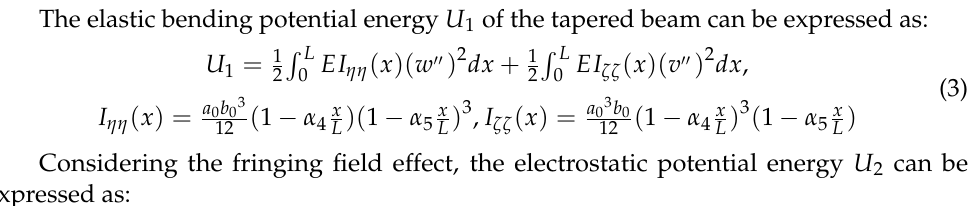
Figure 2. Schematic diagram of Eulerian angle transformation.